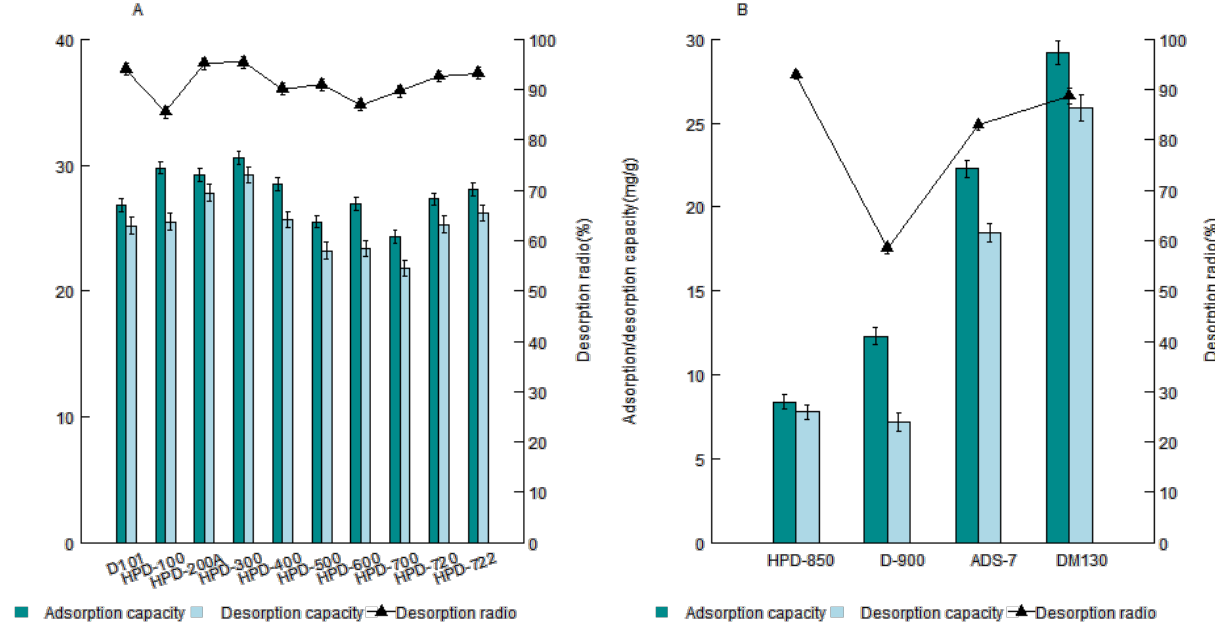
Figure 2. ( A ) Adsorption/desorption capacities and desorption ratio of ASD on the resins for the first step; ( B ) Adsorption/desorption capacities and desorption ratio of ASD on the resins for the second step.